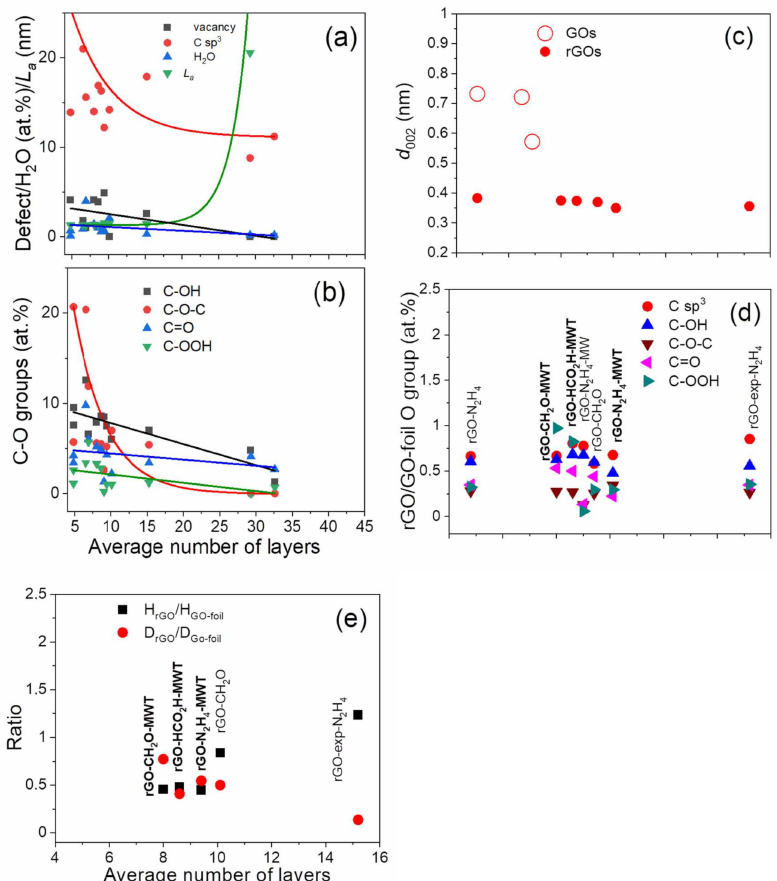
Figure 8. ( a ) Surface atomic content of vacancy, C sp 3 defects, adsorbed H 2 O and effective crystallite size in direction of graphite plane L a , ( b ) carbon-oxygen groups content, ( c ) distance between graphene layers, d 002 , ( d ) ratio of rGO to GO-foil oxygen group content determined from C 1s spectra fitting (Table S2), ( e ) ratio rGO to GO-foil flakes height and diameter resulting from XRD (Table 1) as a function of the average number of